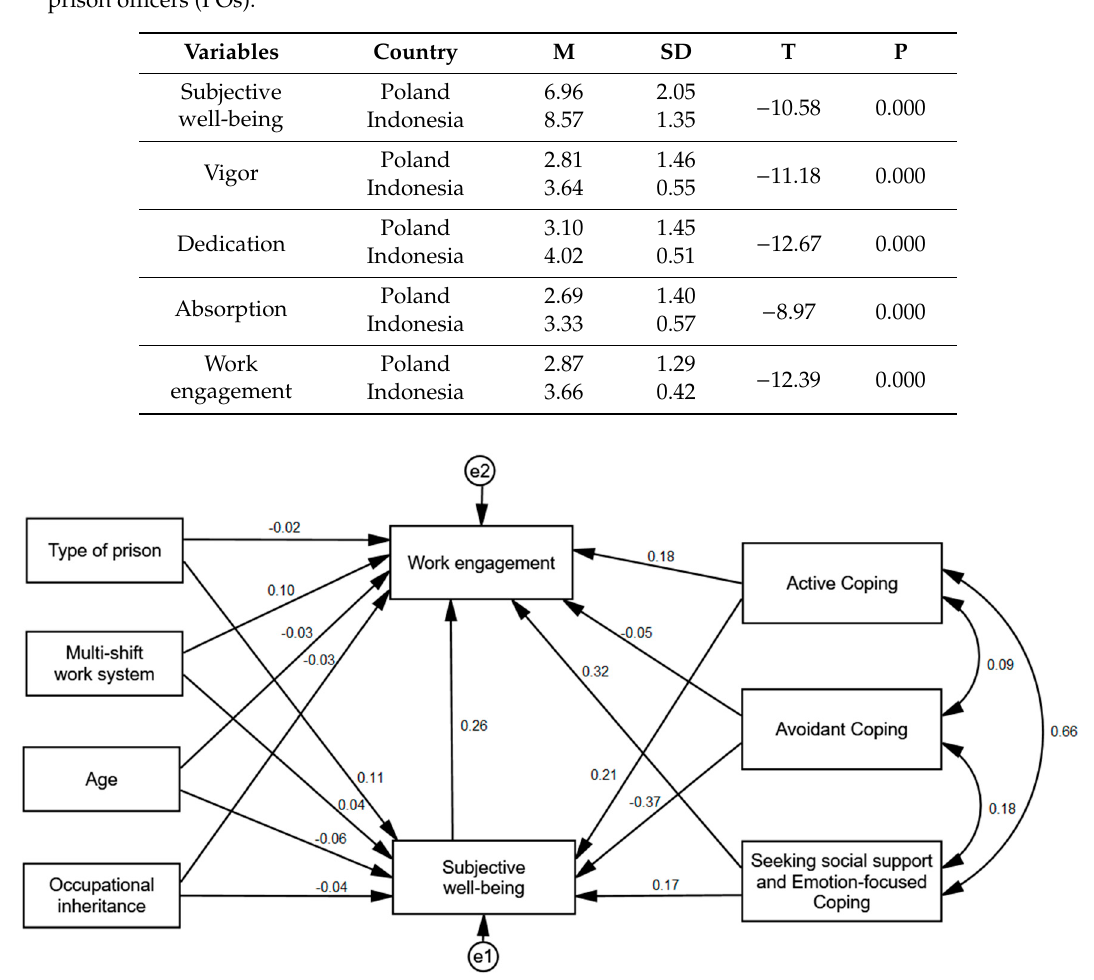
Figure 1. Standardized regression coe ffi cients of the explanatory path model for work engagement.